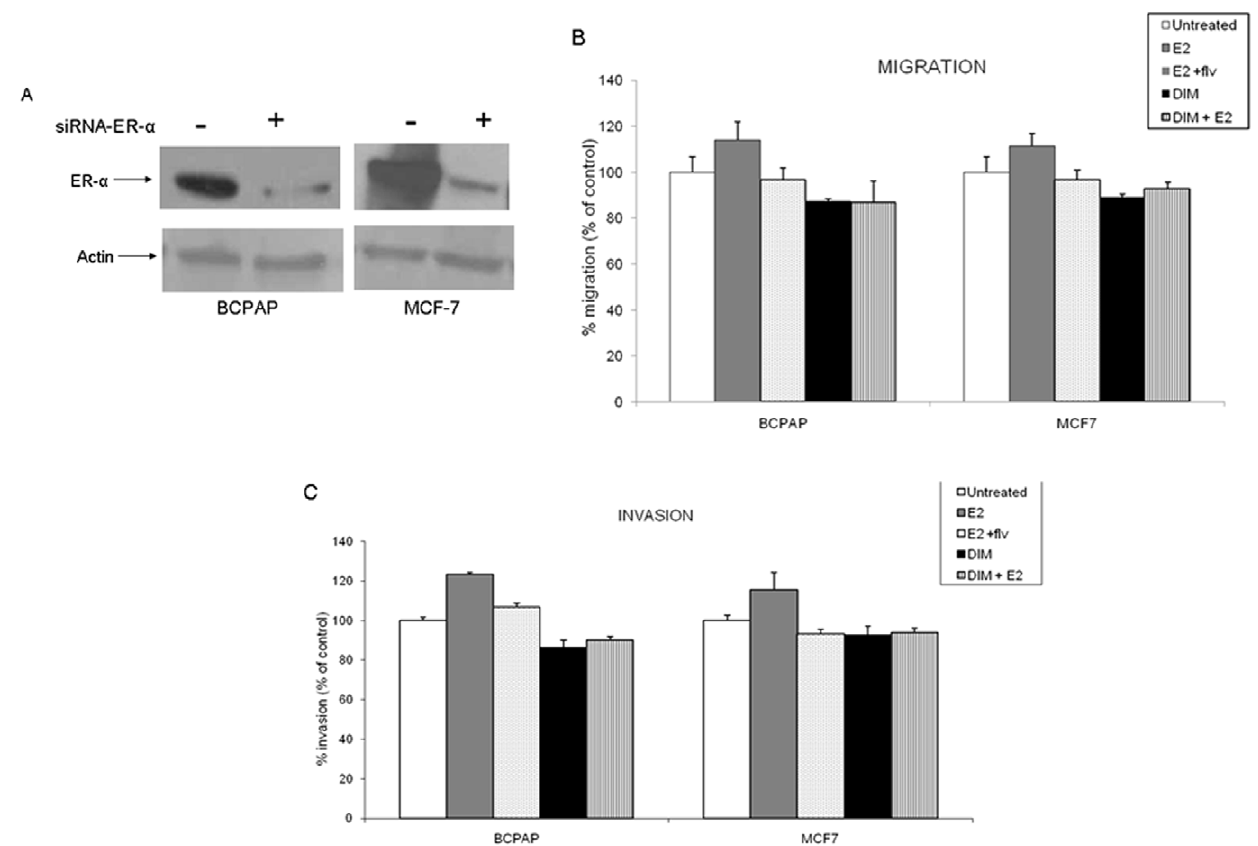
Figure 7. ER- a silencing inhibits DIM’s effect on migration/invasion. (A) Western Blot analysis demonstrating downregulation of ER- a . BCPAP and MCF-7 cells were transfected with siRNA and whole cell protein was resolved by SDS-PAGE followed by Western blot analysis for ER- a . A decrease in ER- a expression was observed for both BCPAP and MCF-7 confirming ER- a silencing. Actin was used as a loading control. (B & C) Cancer cells were transfected with ER- a siRNA and subsequently treated with 10 2 8 M E 2 6 10 2 6 M fulvestrant 6 25 m M DIM or left untreated. Data presented demonstrates percent migration (B) and invasion (C) of ER- a silenced cancer cells treated with E 2 6 fulvestrant 6 DIM compared to untreated ER- a silenced cancer cells which were set to 100%. MCF-7 was used as positive control for ER silencing experiments.